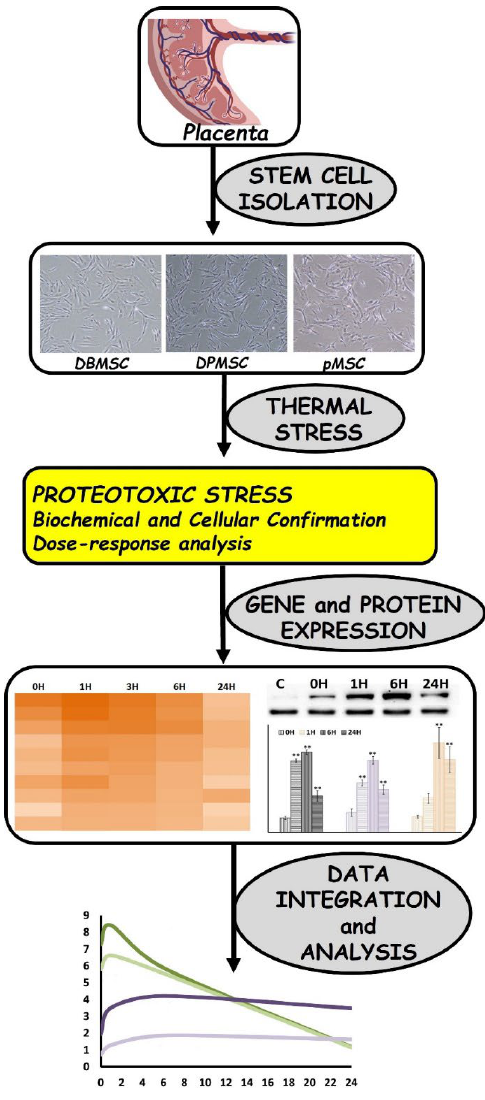
Figure 1. Schematic representation of the research design and methodology. Briefly, the three types of placental origin stem cells—the DBMSCs, DPMSCs, and pMSCs—were isolated from full-term pregnancy placentae. Dose-responsive proteotoxic stress models were developed through induction of thermal stress and validated through biochemical and cell-based assays. Changes in gene expression were analyzed via RT-PCR array, whereas protein expression was monitored through immunoblotting. Kinetic analysis of gene and protein expression was performed to undertake time-series evaluation of stress response. Protein expression is reported to be statistically significant ** at p -values < 0.05.